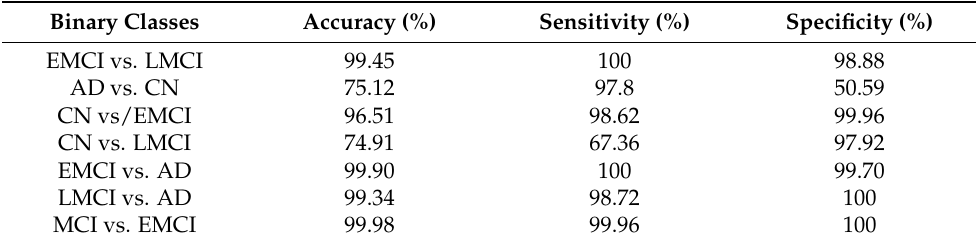
Table 6. Evaluation Metric on Validation Data for Model without Dropout.